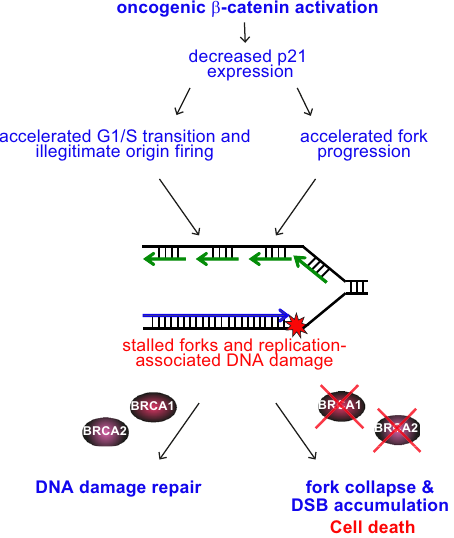
Fig. 8 Mechanism of action of oncogenic β -catenin in BRCA1/2-pro fi cient and -de fi cient cells. Oncogenic β -catenin activation accelerates G1/S transition and fork progression, both mediated by p21 transcriptional downregulation and leading to fork stalling and DSBs accumulation. BRCA1/2-pro fi cient cells can repair oncogene-induced DSBs via homologous recombination. In contrast, in BRCA1/2-de fi cient cells this homologous recombination repair is abrogated, as well as the mechanisms of fork recovery, leading to DSB accumulation to levels incompatible with cell